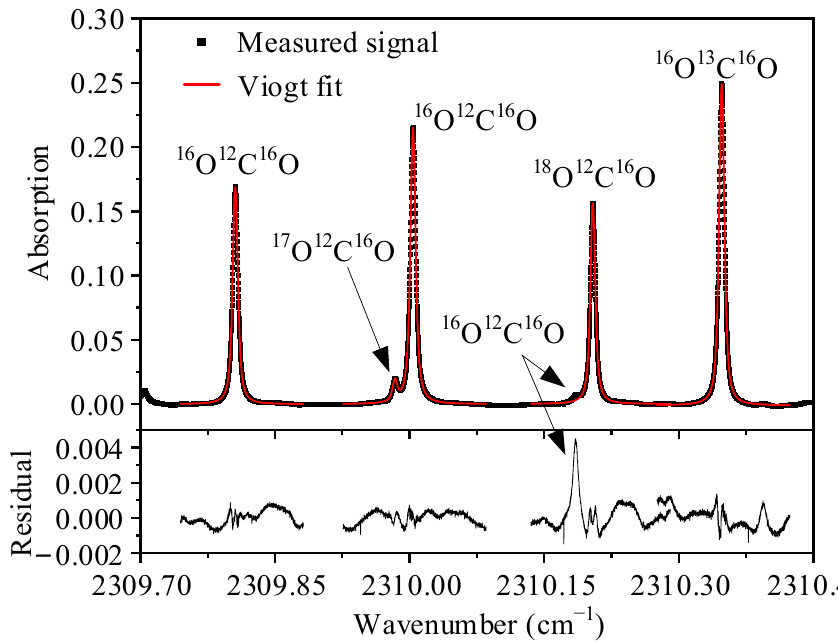
Figure 4. Measured absorption signals fitted to Voigt profile and fitting residuals.